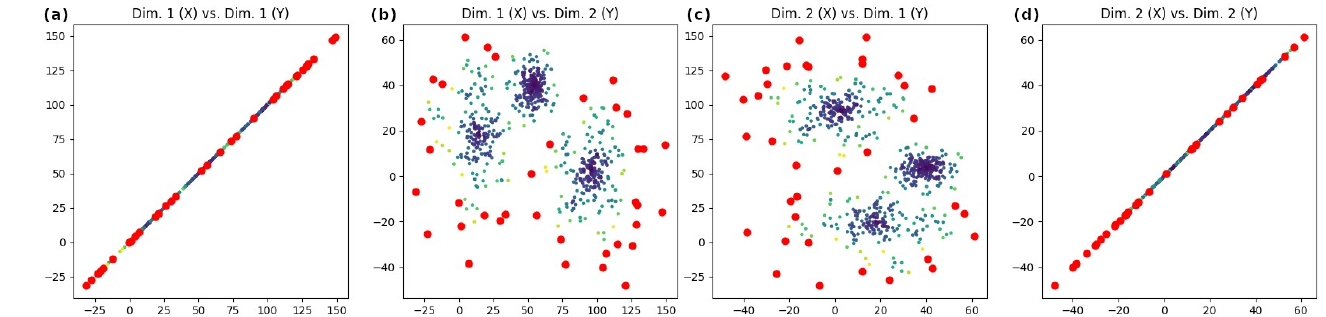
Figure 18. Anomalies for synthetic test data. ( a ) Dimension 1 as X, dimension 1 as Y; ( b ) dimension 1 as X, dimension 2 as Y; ( c ) dimension 2 as X, dimension 1 as Y; ( d ) dimension 2 as X, dimension 2 as